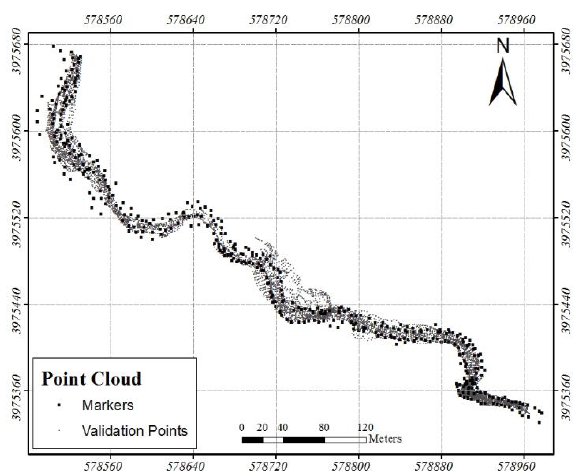
Figure 4. Spatial distribution of validation and ground control points